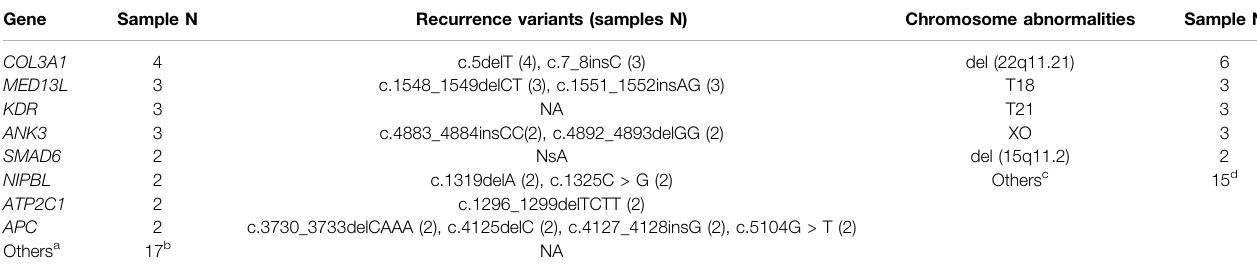
TABLE 3 | De fi nitive or candidate causative variants of WES and low coverage WGS. Gene Sample